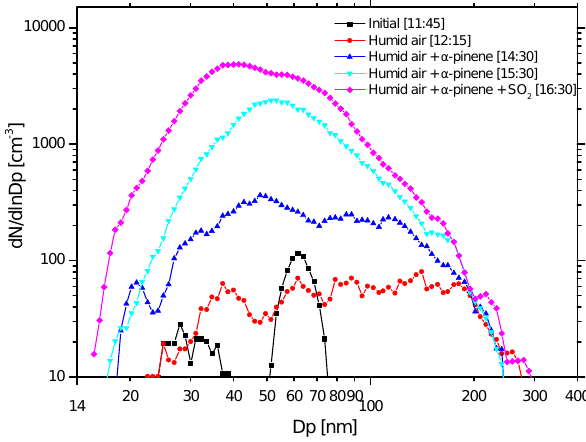
Fig. 10. Evolution of particle sizes for laser-induced particle for- mation in humid synthetic air in the presence of α -pinene and SO 2 at 283K and 94–89% relative humidity. Times in the legend corre- spond to Fig.